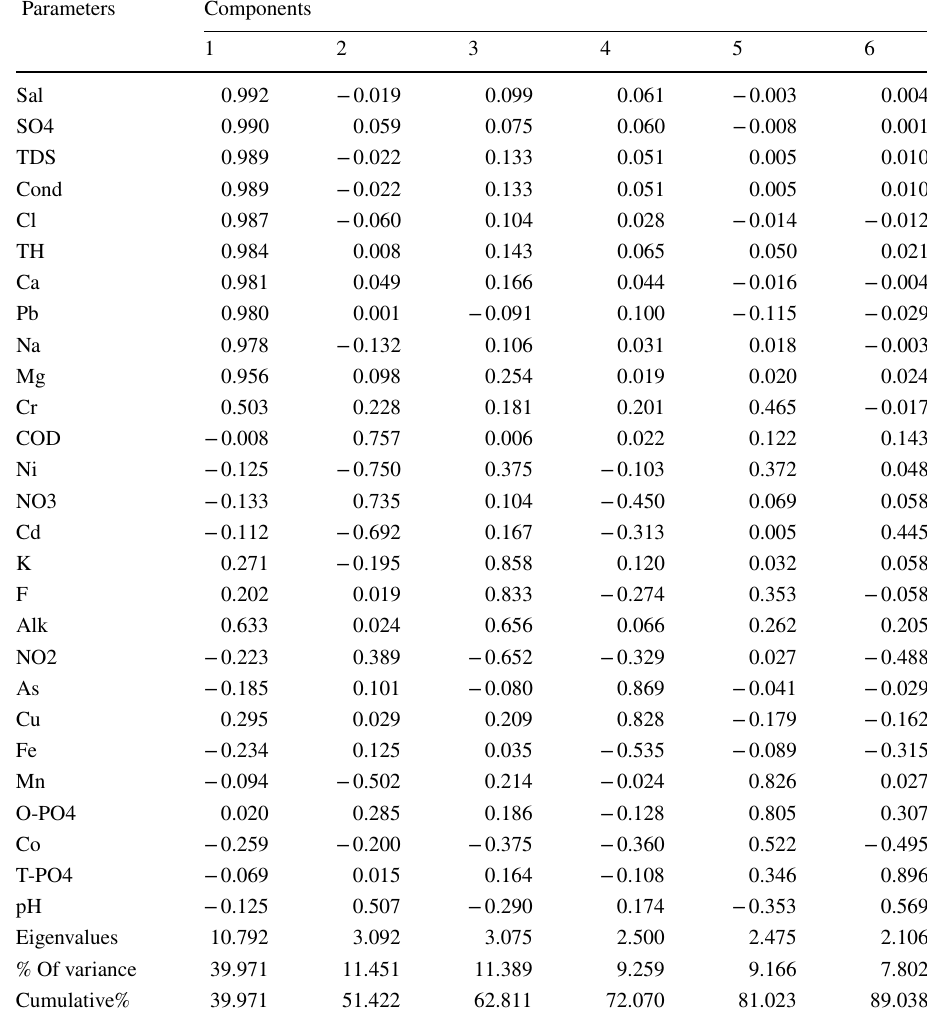
Rotated component matrix